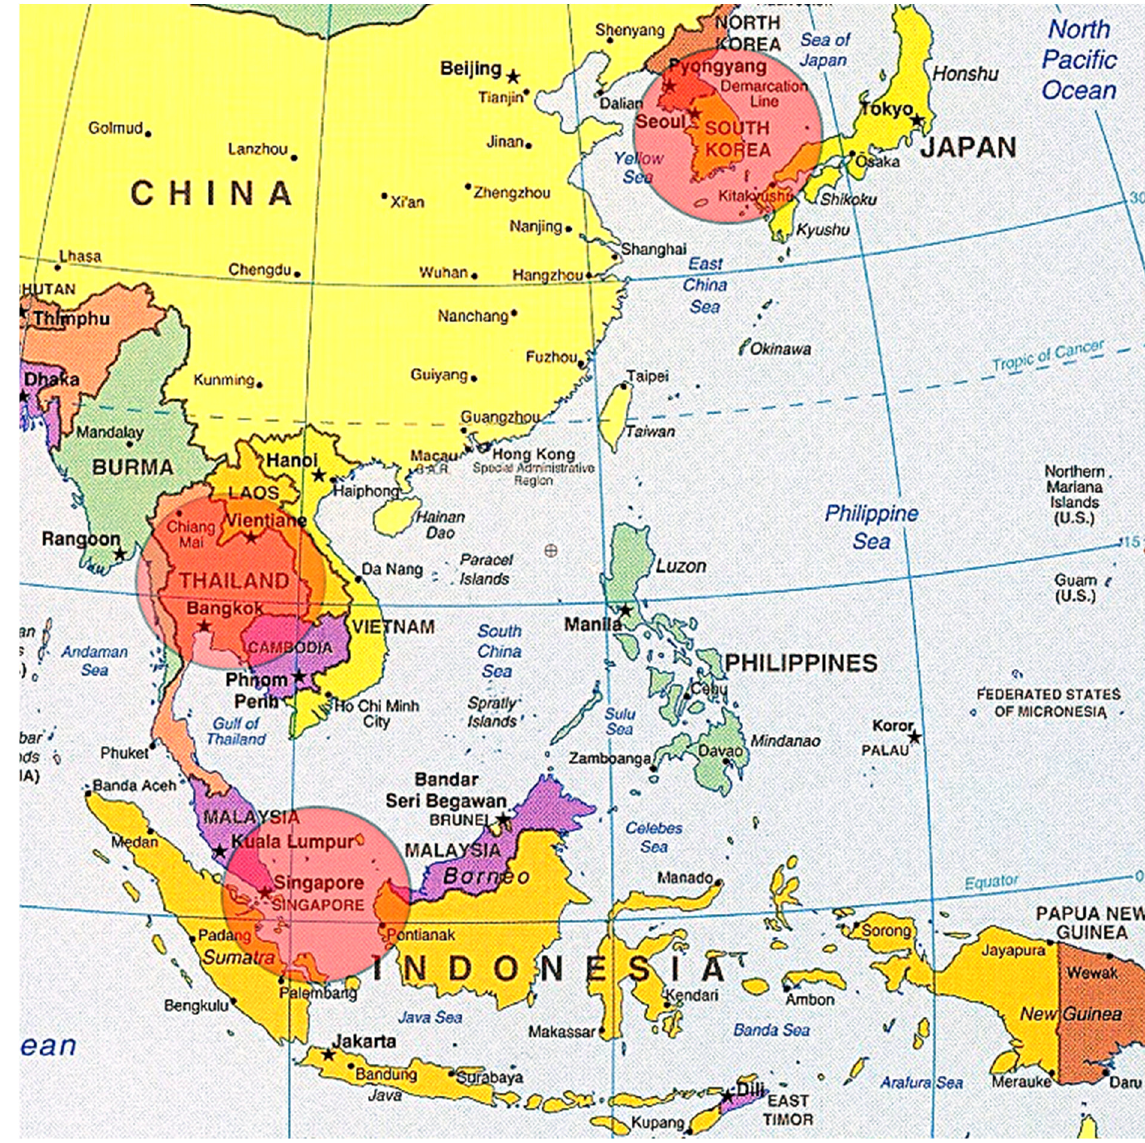
Figure 1. Graphical representation of the survey distribution in the three countries (Thailand, Singapore, and Korea).